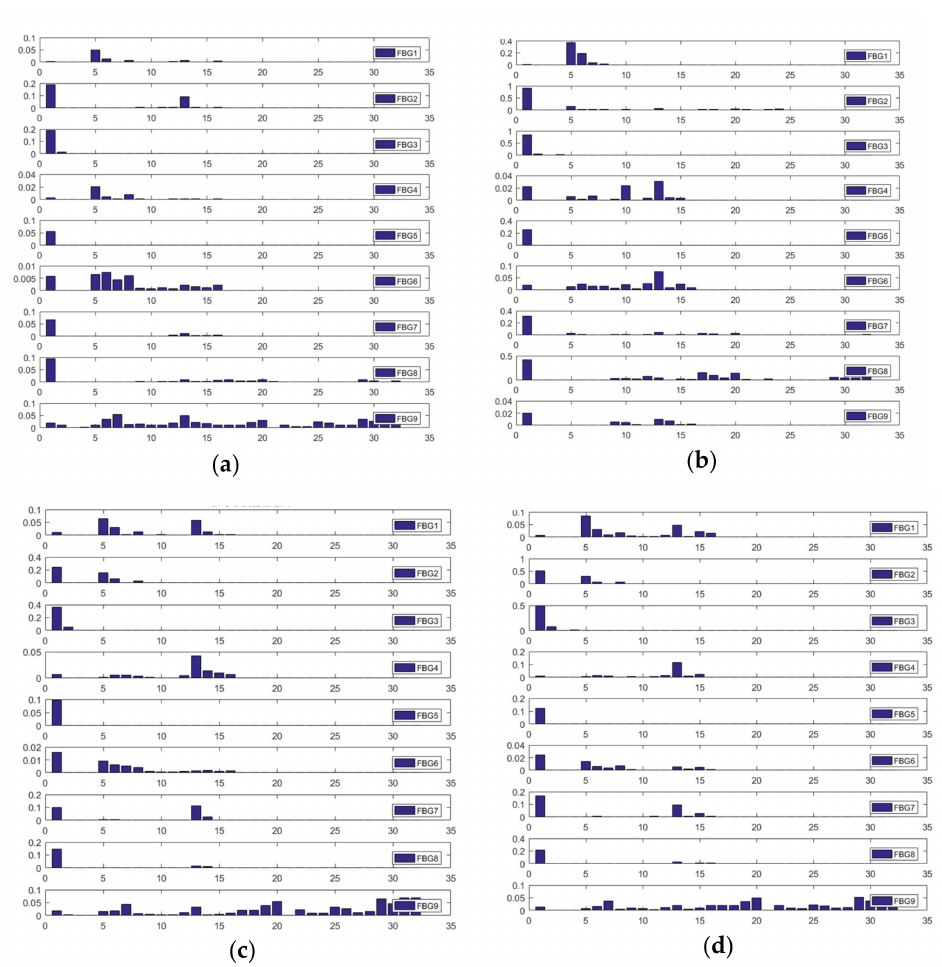
Figure 11. Wavelet packet energy spectrum of repeated impacts at ( − 81 mm, 81 mm): ( a ) first impact; ( b ) second impact; ( c ) third impact; ( d ) fourth